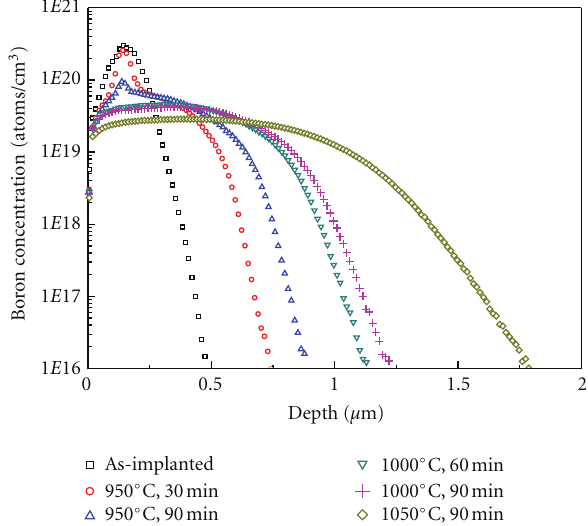
Figure 1: SIMS profiles of boron-implanted emitters as a function of annealing